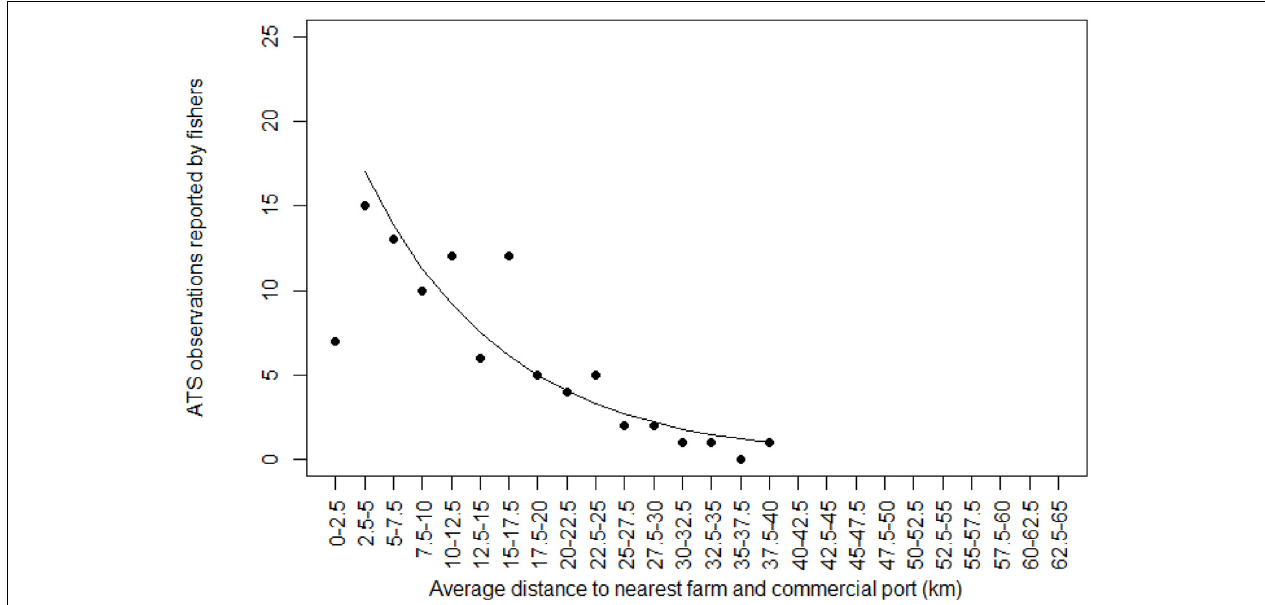
FIGURE 5 | Relationship between Abnormally Tough Specimen (ATS) observations reported by fishers and average distance between the nearest farm and the nearest commercial port. The black line is prediction from glm (first distance class 0–2.5 km count removed).